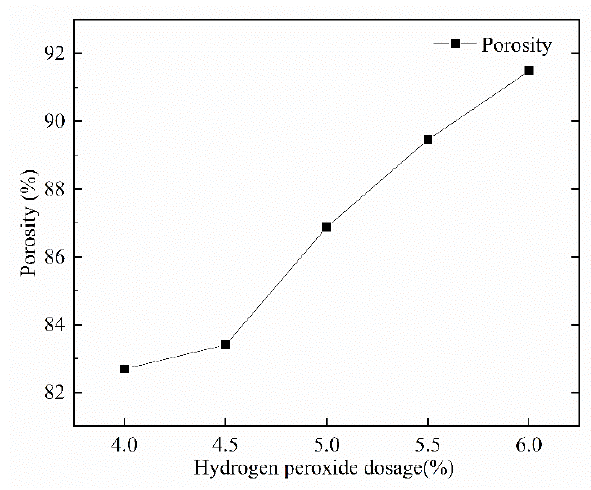
Figure 10. Pore cross-sectional image of 4% of foam dosing: ( a ) original image, ( b ) cross-sectional image.